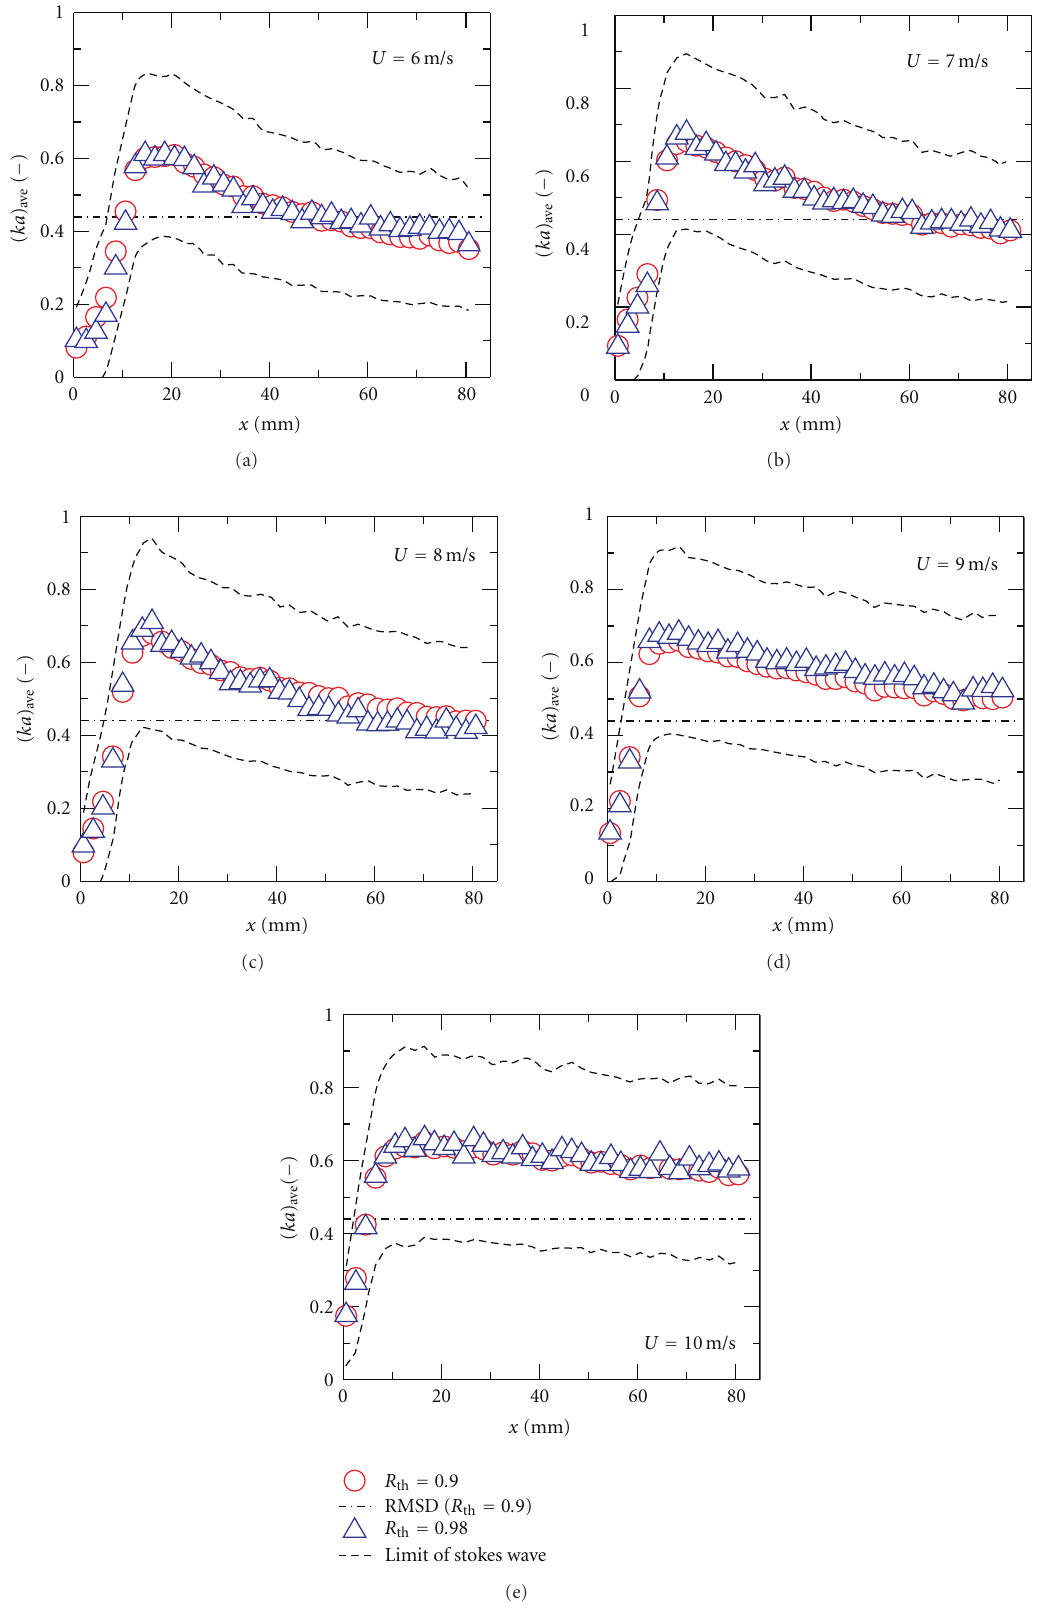
Figure 10: Local value of mean wave